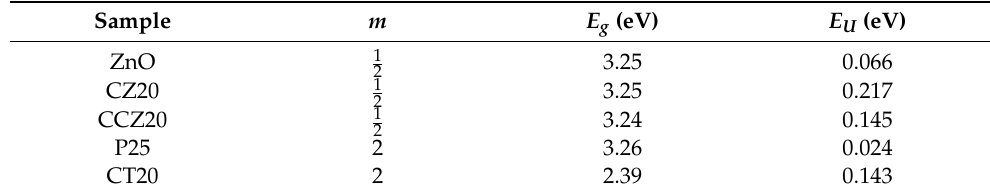
Table 2. Calculated band gap values and Urbach energies obtained via Tauc plot and Urbach plot methods, respectively.